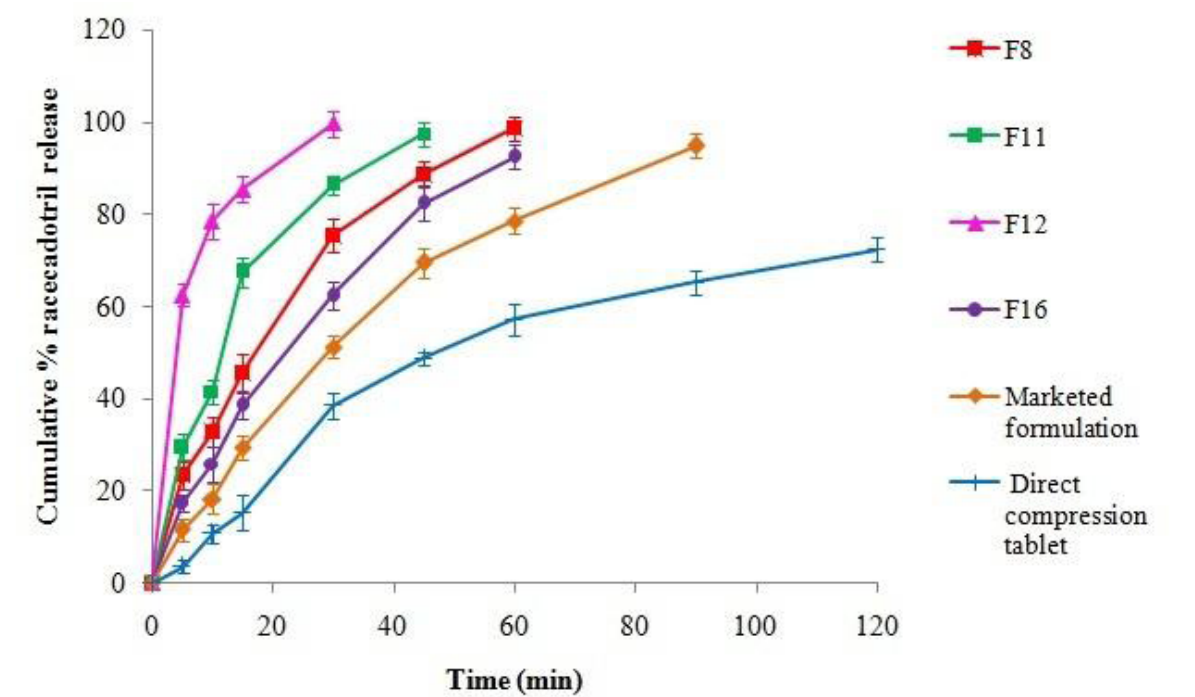
FIGURE 1 - Comparison of release of RT from liquisolid tablets, conventional direct compression tablets and marketed tablets